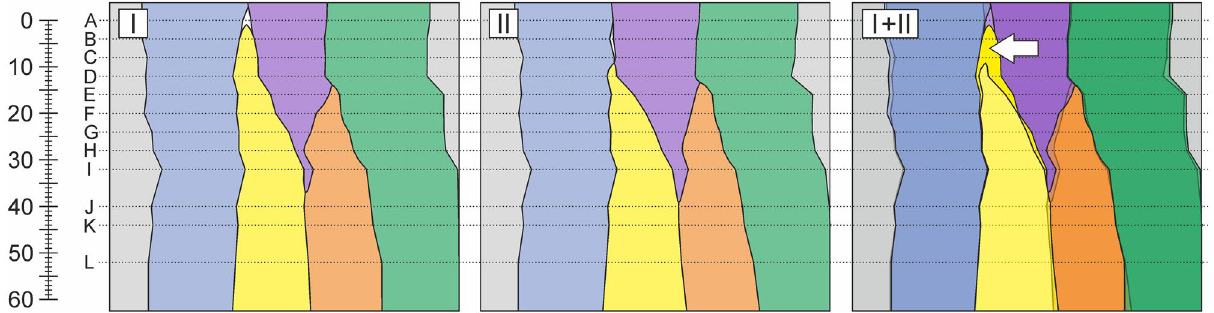
Figure 8. Anatomical reconstructions of tangential planes of the vascular cambium of Robinia pseudoacacia L. Scale on the left is expressed in μm. ( I ) Reconstruction of tangential plane I indicated in Fig. 6. ( II ) Reconstruction of tangential plane II indicated in Fig. 6. Plane I is localised in close vicinity of the cambial initial surface. Plane II is localised closer towards the xylem side. ( I + II ) Superposed reconstructions of tangential planes I and II, showing that intrusive growth of the initial cell does not contribute to the increase in tangential dimension of analysed fragment of the tissue, and therefore do not increase the circumference of cambial cylinder in examined tree trunk. It also indicates that growth of the initial cell occurred between tangential cell walls of neighbouring cells. White arrow indicates part of the cell which grew intrusively. CorelDRAW Graphics Suite SE ver. 18.2.0.840 (https:// www. corel draw. com) was